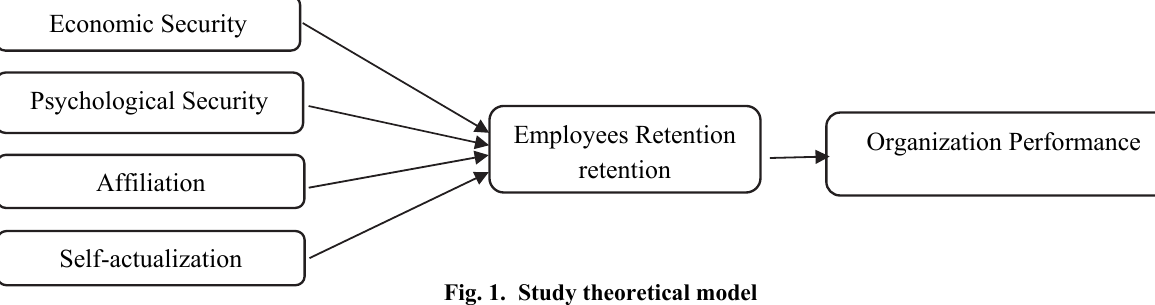
Fig. 1. Study theoretical